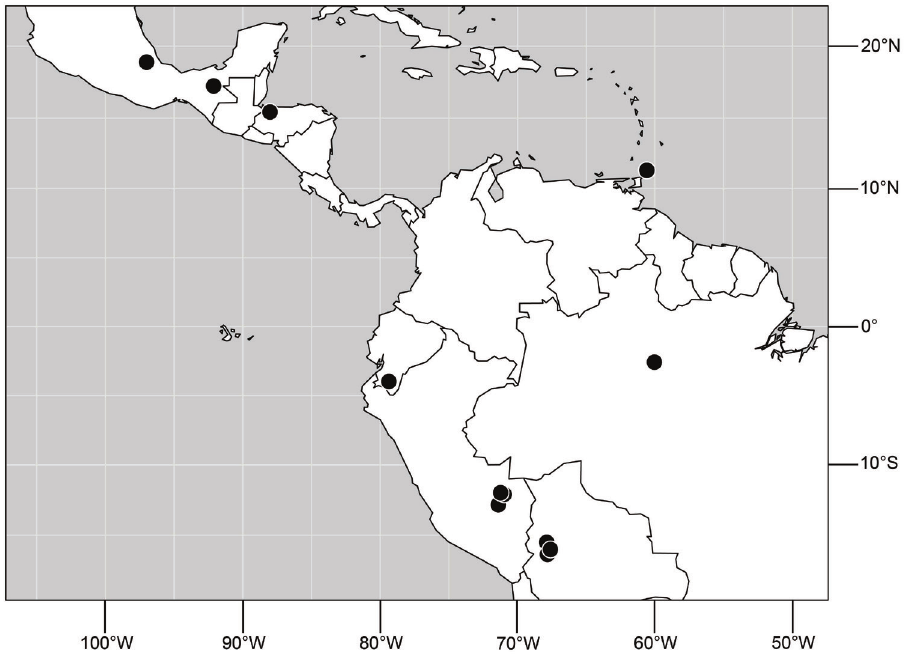
Figure 85. Distribution of Hydrochasma falcatum sp.